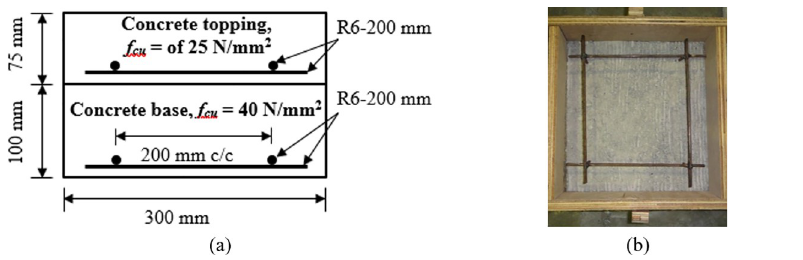
Fig 2. “Push-off” specimen a) Schematic of reinforcement details, and b) Actual reinforcement.